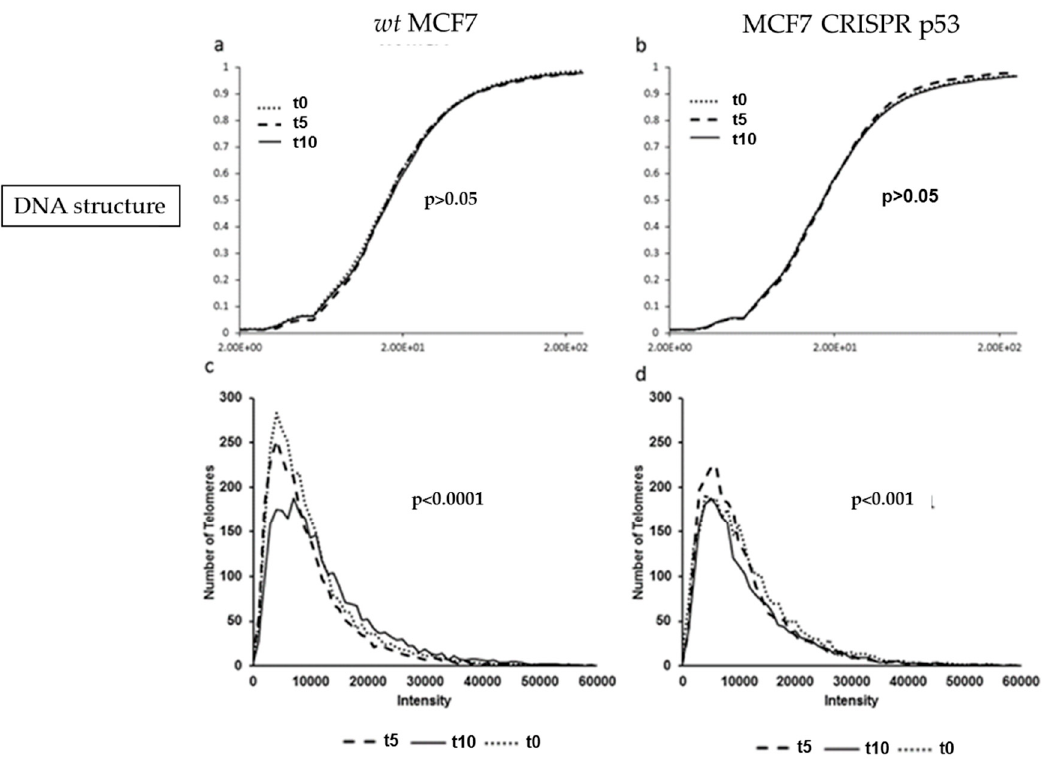
Figure 6. Comparison of DNA structure (using granulometry) and telomere histograms between the MCF7 (wild-type and CRISPR-p53) after 0, 5 or 10 h of Nutlin-3 treatment. ( a ) and ( b ) show the cumulative distribution of DNA structure. ( c ) and ( d ) show the telomere length (signal intensity in arbitrary units) on the x-axis against the number of telomeres on the y-axis. The p -values demonstrate the comparison between t0 or t5 with t10.